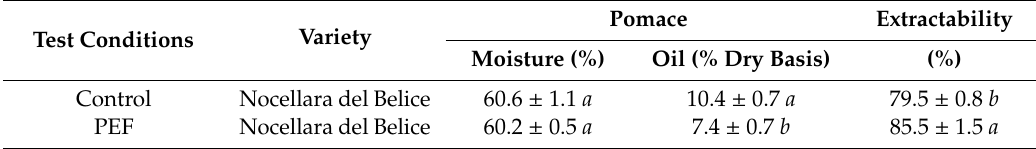
Table 1. Quantitative results and process